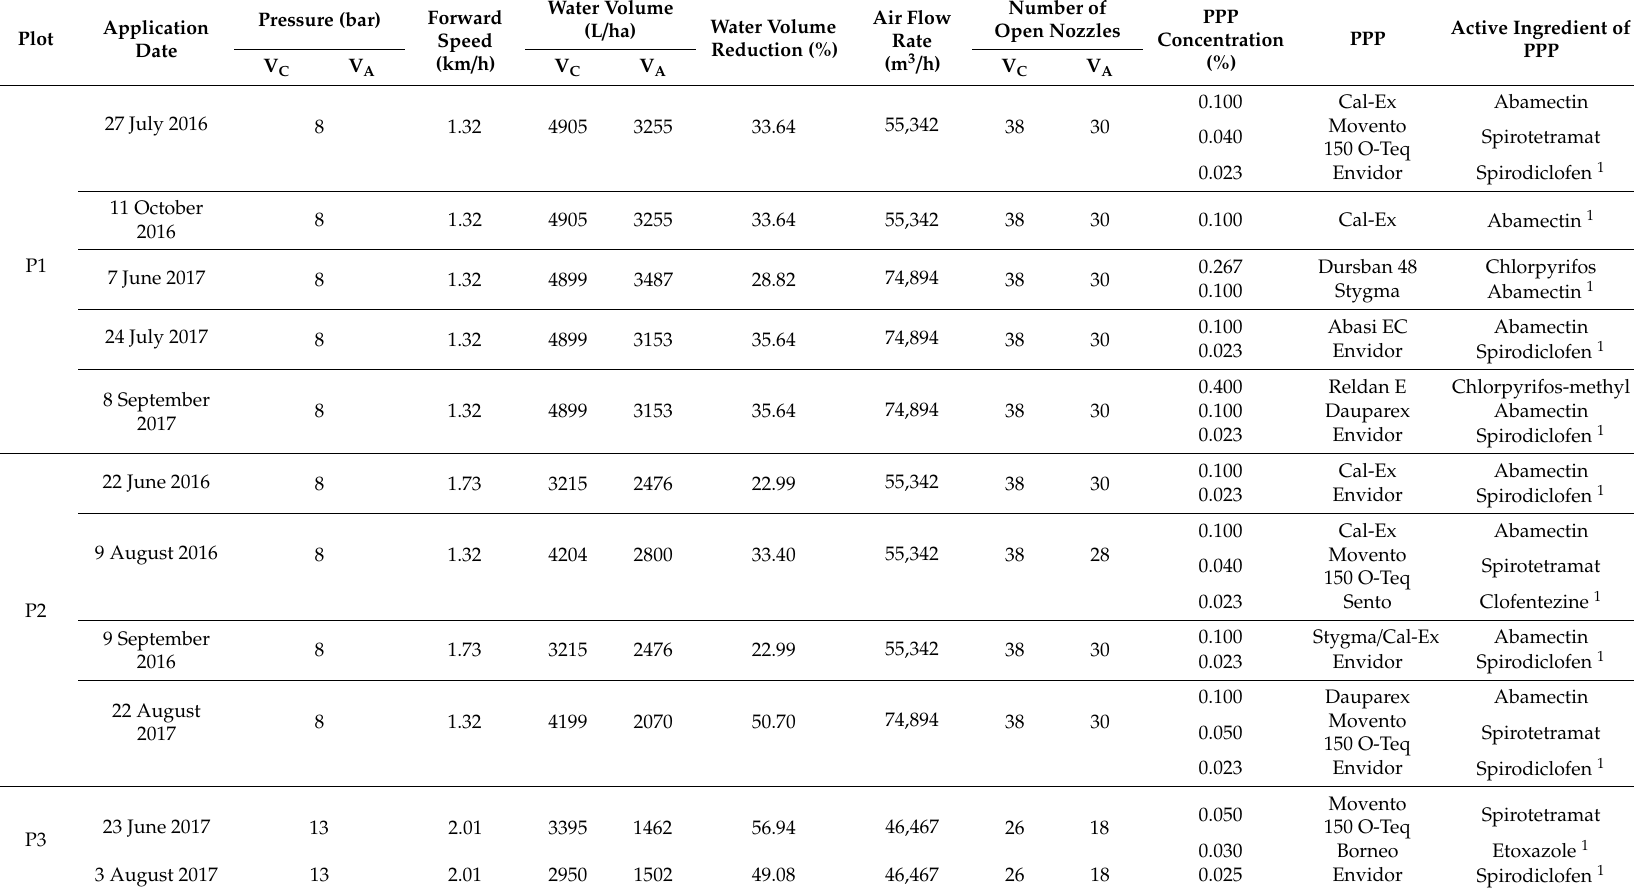
Table 3. Operative characteristics of plant protection products (PPP)